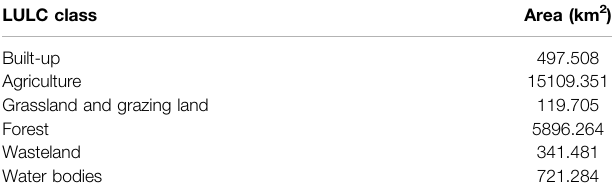
TABLE 1 | Land use land cover (LULC) classes in the Ramganga basin.